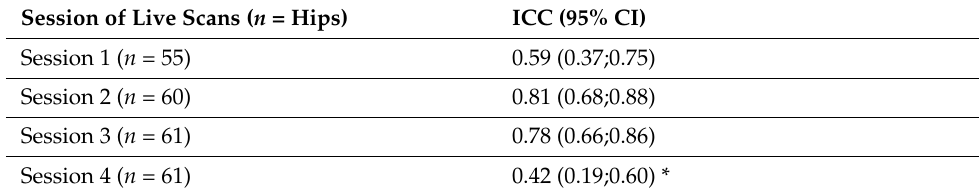
Table 3. Inter-rater ICCs of PFD measurements made by recruited midwives and supervising radiologists across four sessions of live scans. ICC = Inter-rater correlation